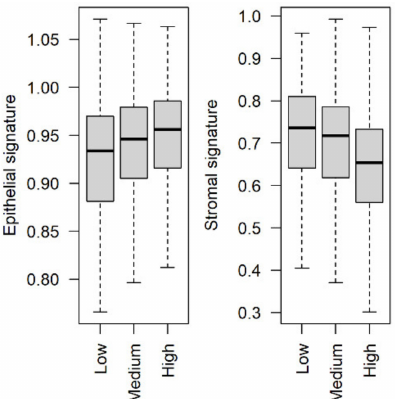
Figure 8. Correlation between epithelial or stromal markers and cellularity in the METABRIC cohort. Epithelial and stromal signatures were obtained through a meta-analysis comparing the expression patterns of tumor stroma and epithelium. The signatures were then used to build stromal and epithelial scores representing cell proportions for each tumor sample in the METABRIC cohort and correlated with clinician annotation of